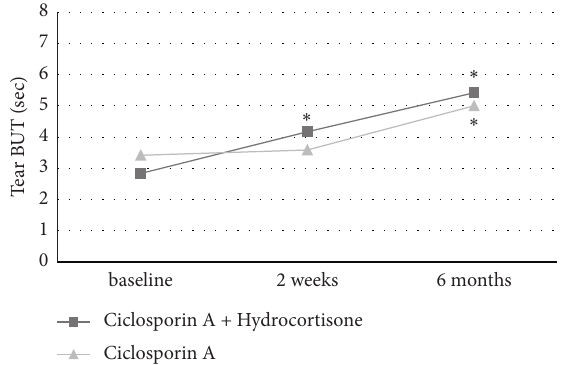
Figure 5: Schirmer test in both treatment groups at baseline, after 2 weeks, and after 6 months of treatment. Significant differences to baseline are marked with ∗